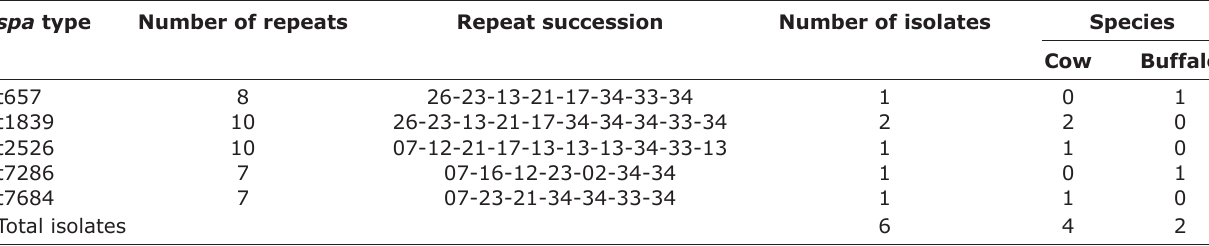
Table-5: Summary of spa types found in PVL-positive isolates. spa